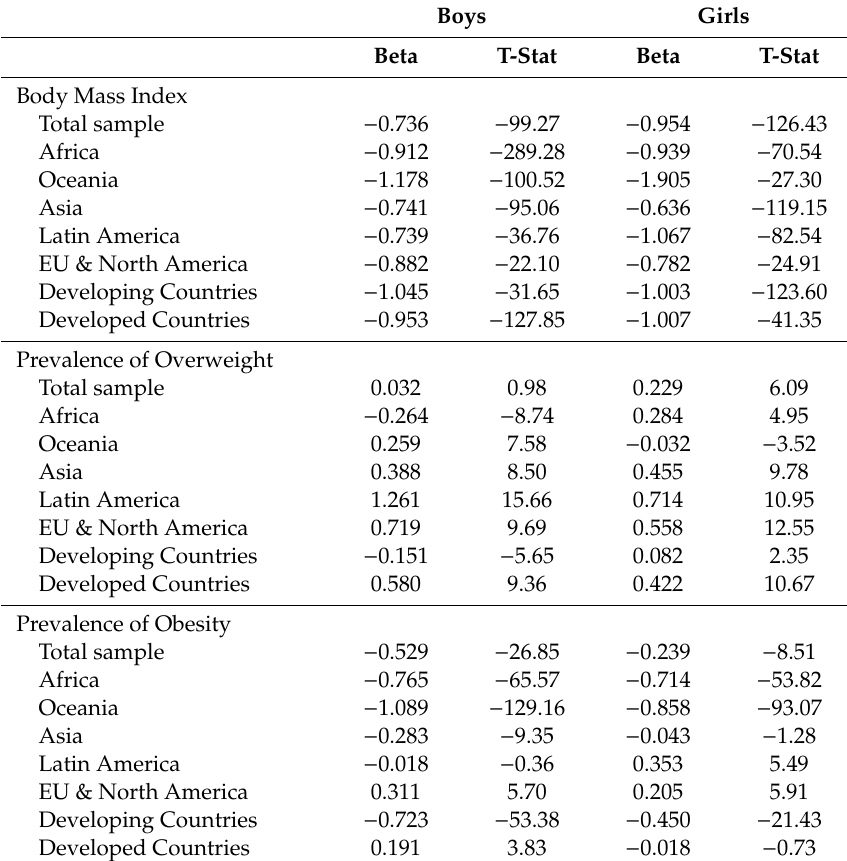
Table 2. Estimated parameters and t-test statistics of the convergence